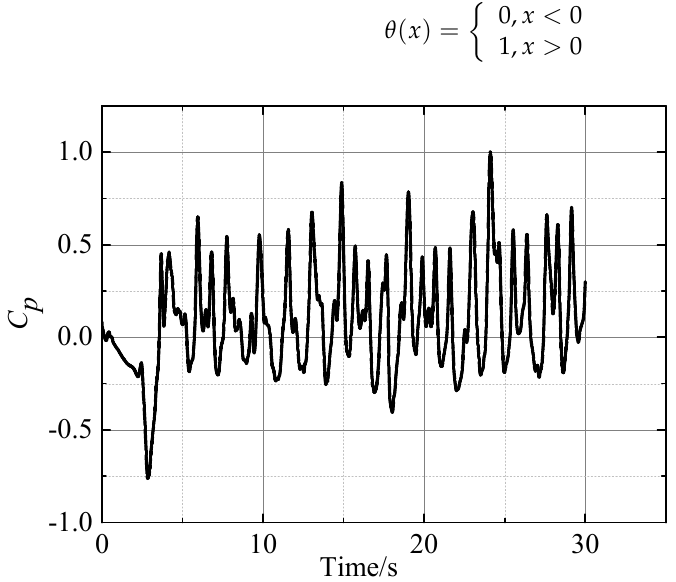
Figure 6. The original signal spectrum.